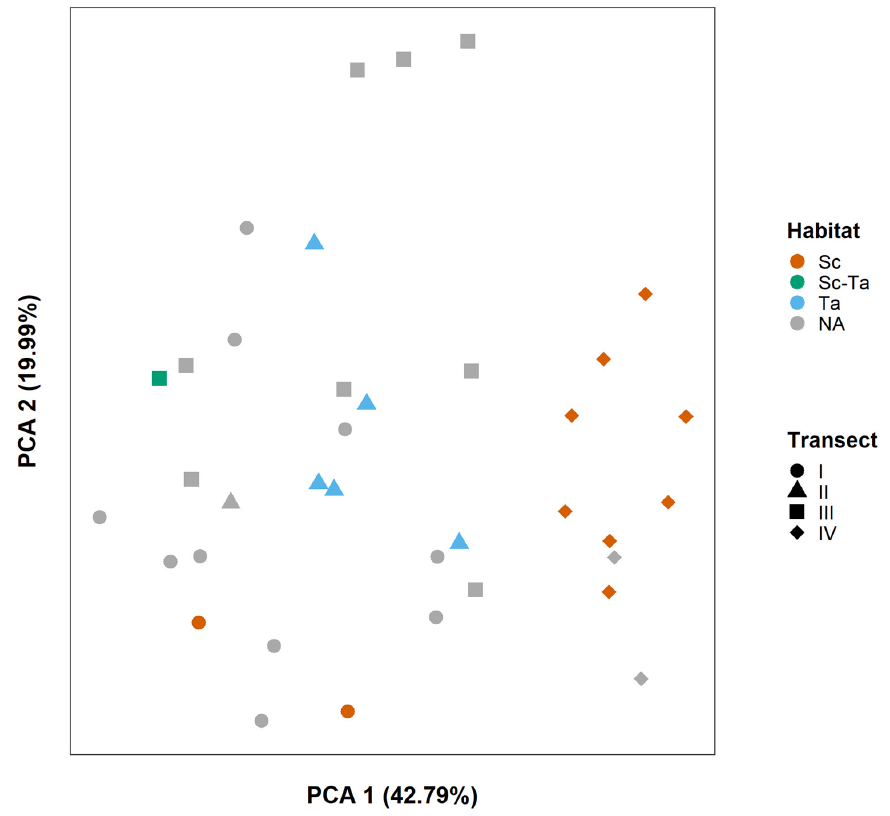
Figure 4. PCA ordination diagram on Kalametiya Lagoon feeding guilds abundance variation among study sites. It uses the two first ordination axes, PC1 and PC2, displayed on the left and bottom sides of the figure with their explained proportion in percentages. For habitat labels, cf. Table 1, except for NA, which is used for sites with no habitat affiliation. The shape of the dots displays transect affiliation: circle for Transect I, triangle for Transect II, square for Transect III, and diamond for Transect IV.